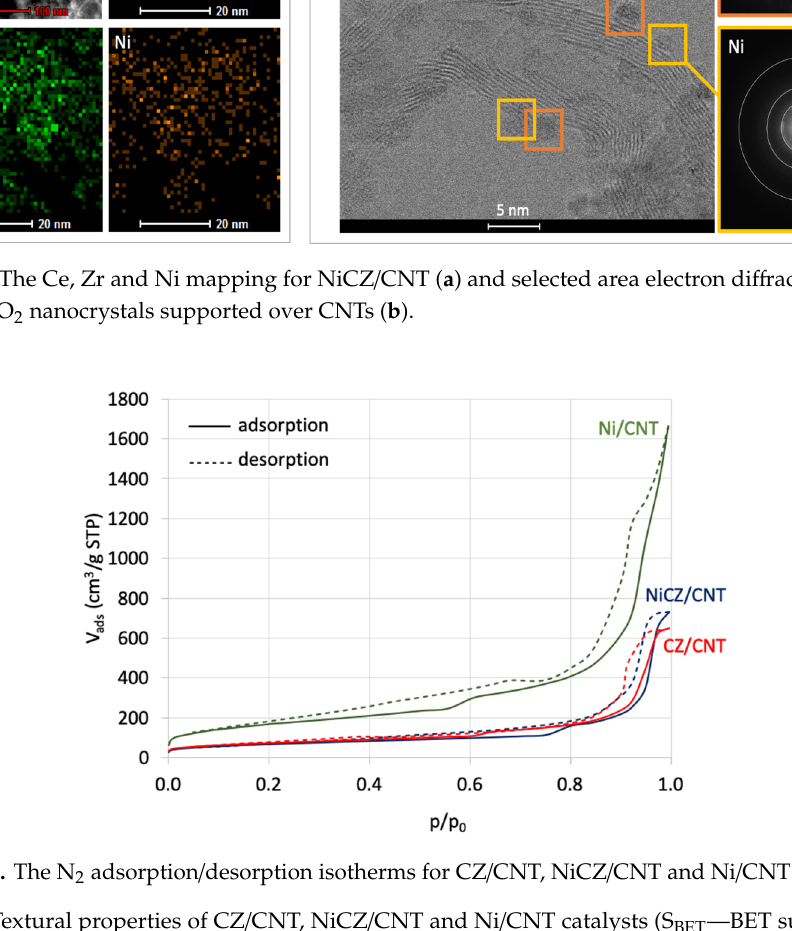
Table 1. Textural properties of CZ/CNT, NiCZ/CNT and Ni/CNT catalysts (S BET —BET surface area, V t — total pore volume, V micro — volume of micropores, V macro — volume of macropores, d— mean